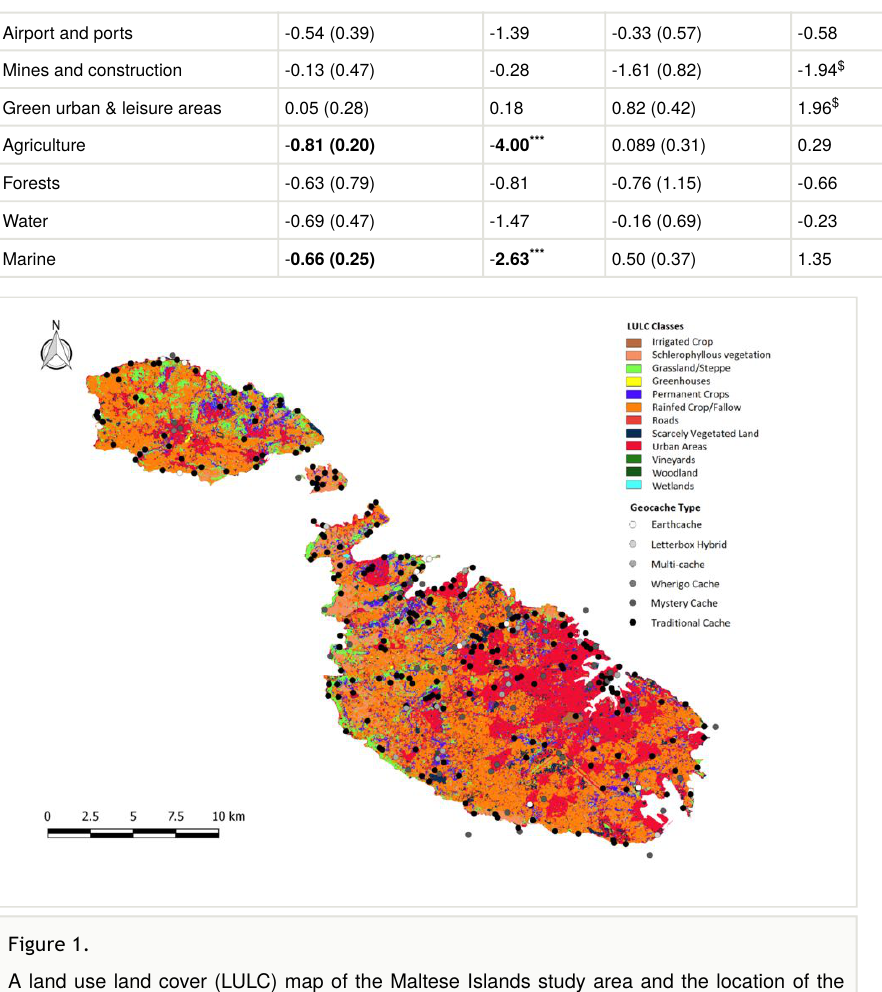
Figure 1. A land use land cover (LULC) map of the Maltese Islands study area and the location of the investigated geocaches according to the cache